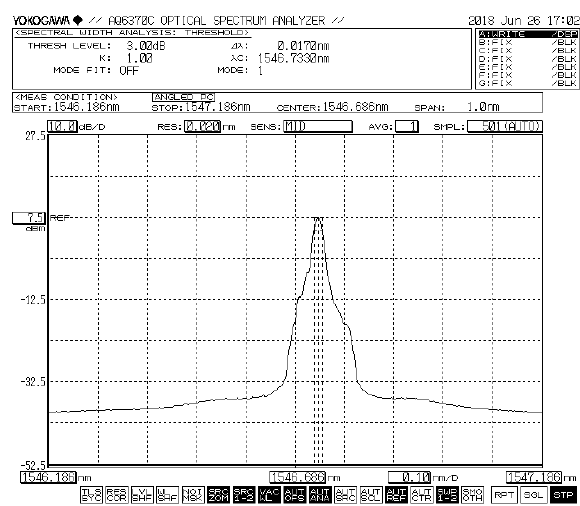
Figure 5. Typical laser signal with the wavelength centered at 1546.733 nm.